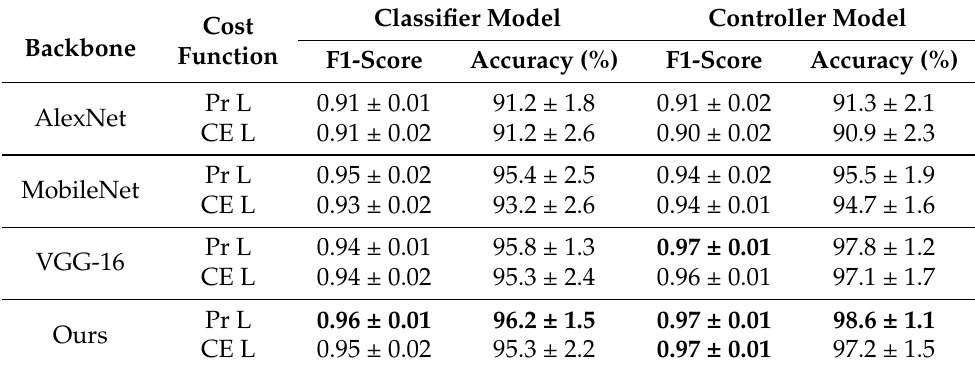
Table 9. Performance comparison between the proposed models with AlexNet, MobileNetV2, and VGG16. The results on the test sets are measured by accuracy and F1-Score (mean ± std). For each measurement, the best result is bold. PR-L and CE-L indicate the proposed loss and Cross-Entropy loss,